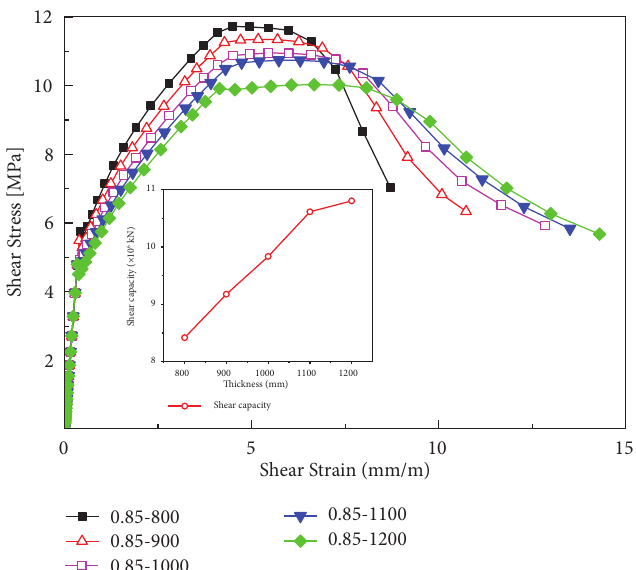
Figure 13: The influence of the thickness of the core region on the shear performance.